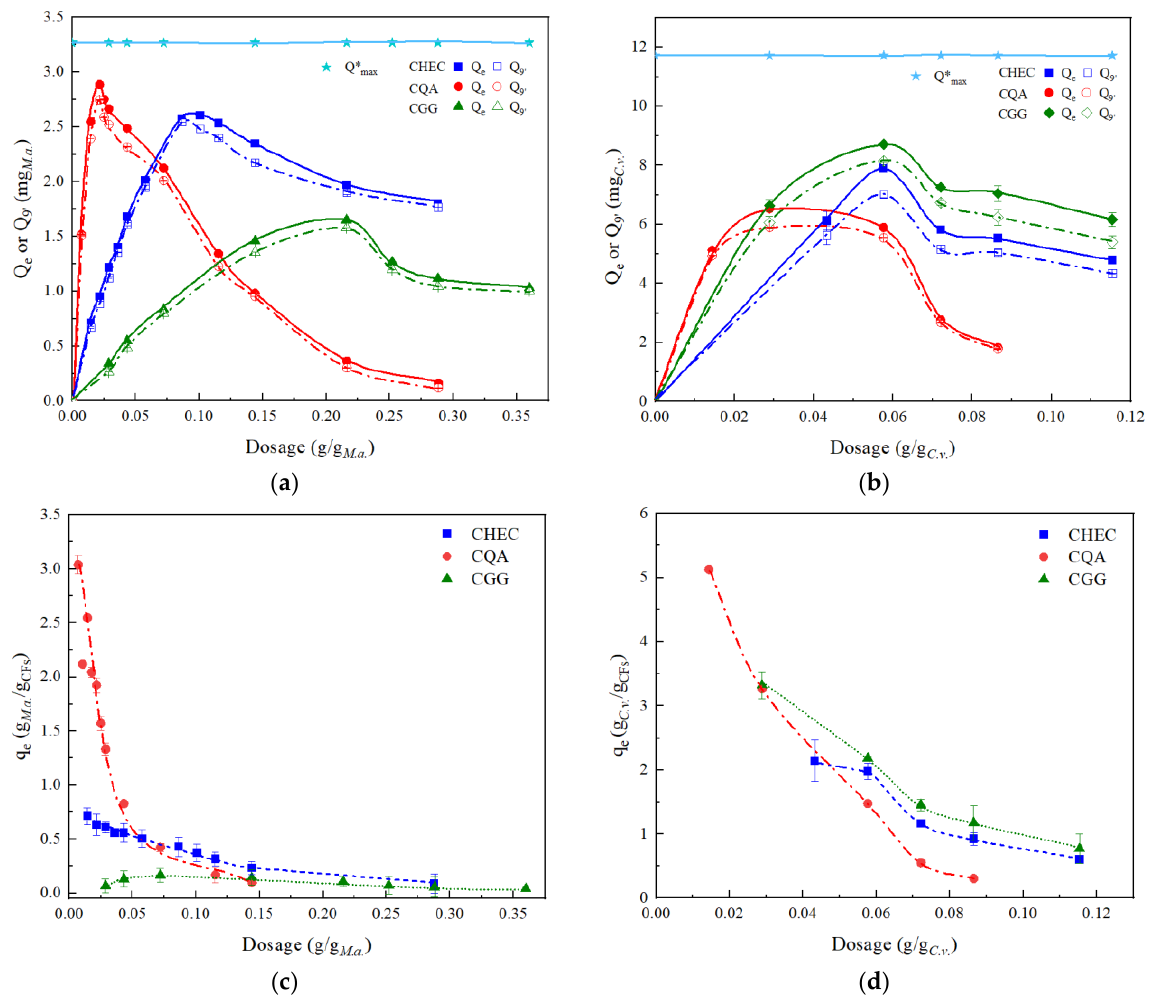
Figure 3. Coagulation amount and adsorption capacity derived from TR kinetic measurements of M. aeruginosa and C. vulgaris : ( a ) Q e and Q 9′ for M. aeruginosa ; ( b ) Q e and Q 9′ for C. vulgaris ; ( c ) q e for M. aeruginosa ; ( d ) q e for C. vulgaris. * Q max is theoretical maximum Qe according to the addition amount. Table 1. Parameters of pseudo-second-order kinetics models for comparison of different microalgae. q e Dosage k s k s · q e 2 Microalgae PBCFs R 2 (g CFs /g m ) (g CFs /g m /min) (g m /g CFs ) (g m · g CFs /min) CHEC 0.07 M. aeruginosa S. platensis CQA